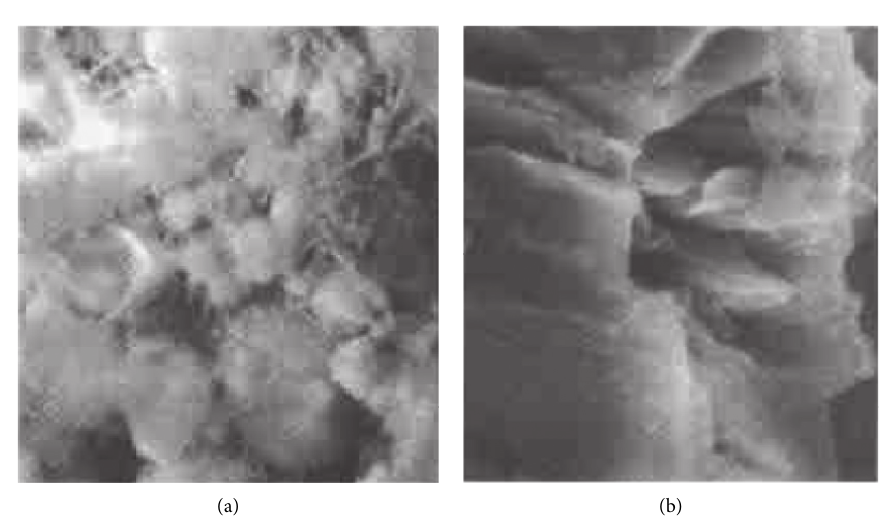
Figure 10: Material SEM photo. (a) Curing period: 3 days. (b) Curing period 28 days.